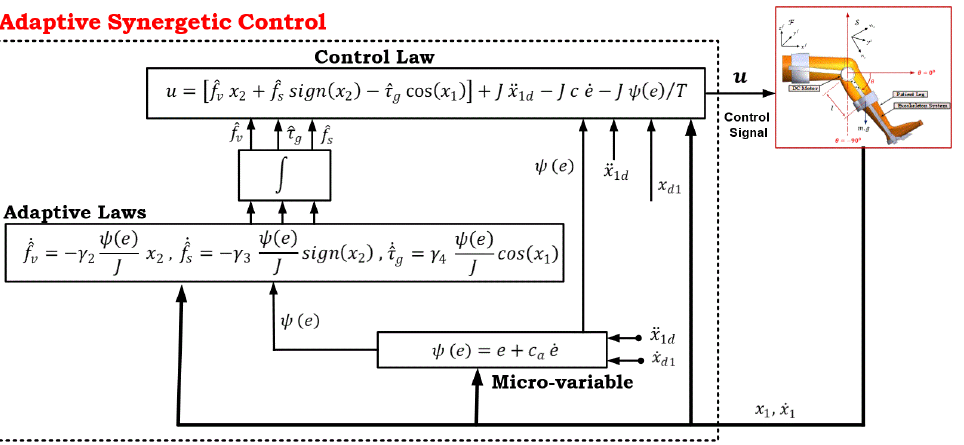
Figure 2. The realization of adaptive synergetic control for exoskeleton assistive devices for knee rehabilitation.